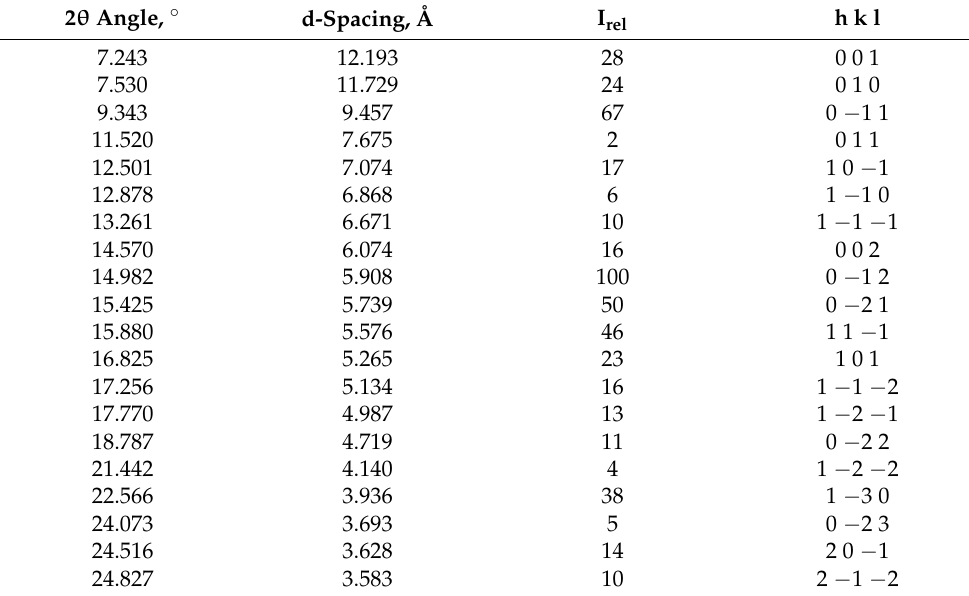
Table 3. List of observed 2 θ angles, d-spacings, and relative intensities, jointly with reflection indices, for Eltrombopag Form